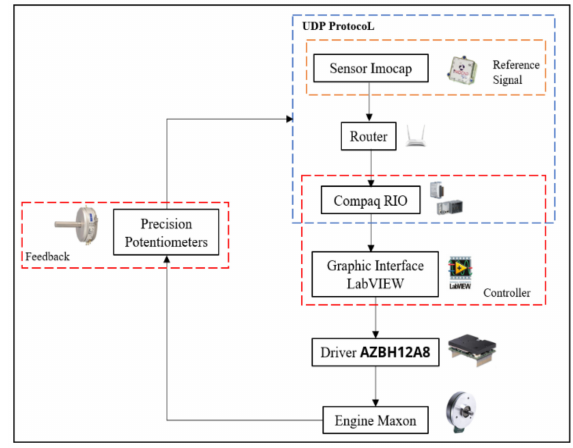
Figure 6. Block diagram of the integration. Obtaining Exoskeleton Equations